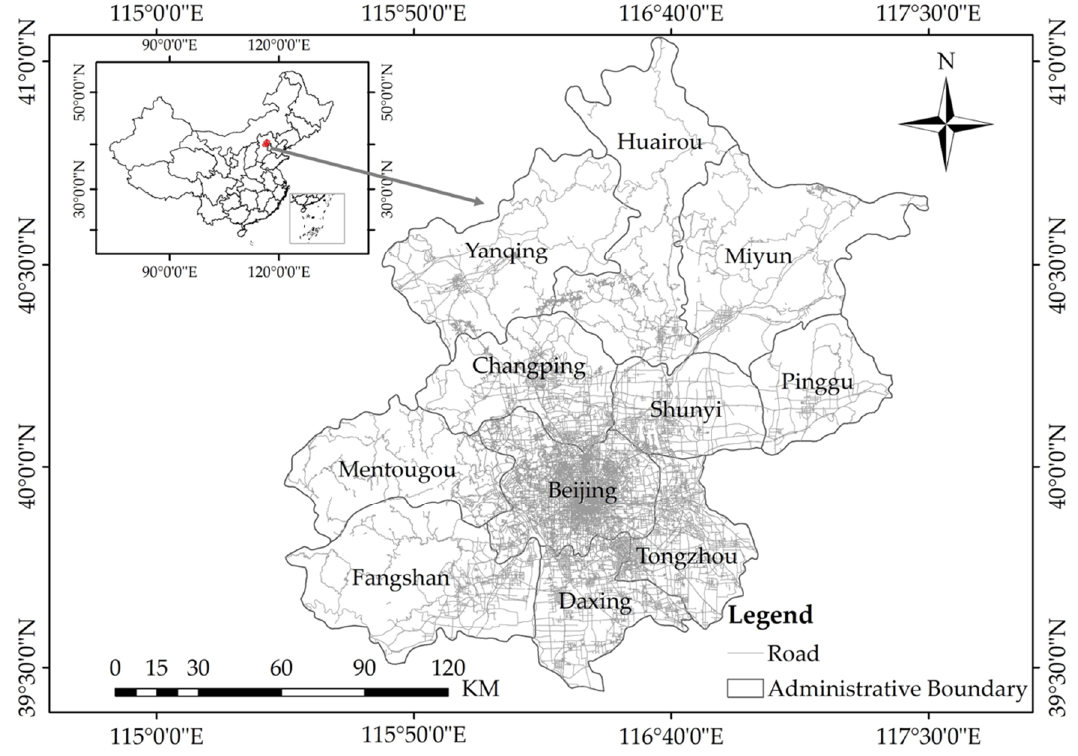
Figure 1. Geographical location of Beijing, China.